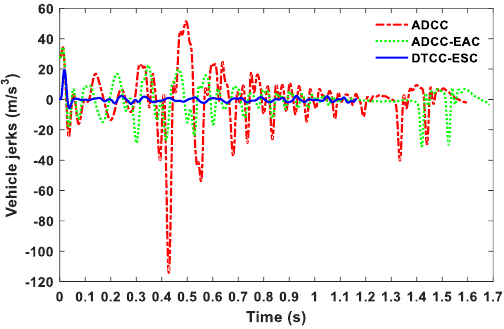
Figure 21. Jerk results of three control methods under case D.